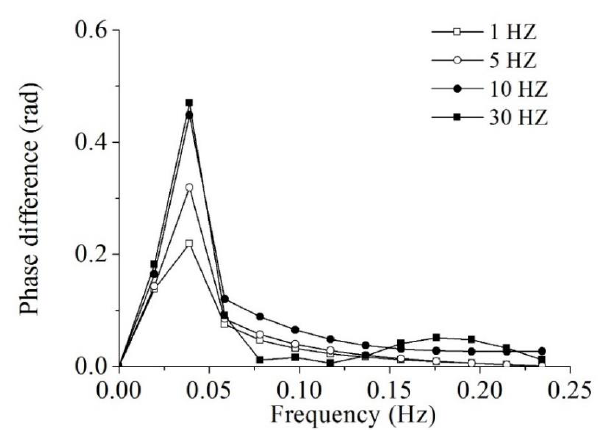
Figure 7. Phase di ff erence variations for di ff erent sampling